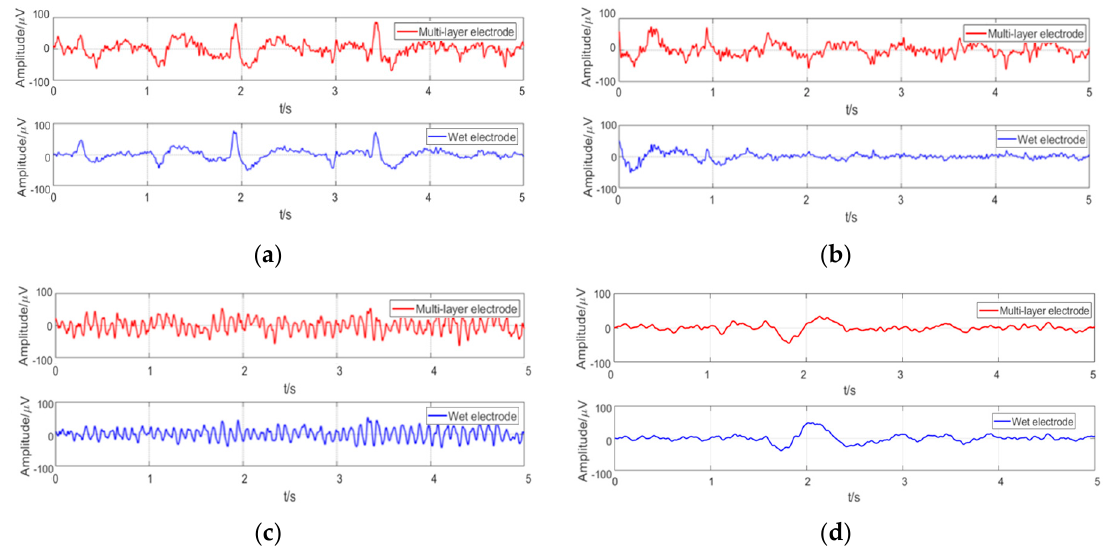
Figure 9. Typical EEG collected under different conditions in the eyes close/open experiment: ( a ) EEG at the Fpz with closed eyes; ( b ) EEG at the Fpz with opening eyes; ( c ) EEG at the Oz with closed eyes; ( d ) EEG at the Oz with opening eyes.